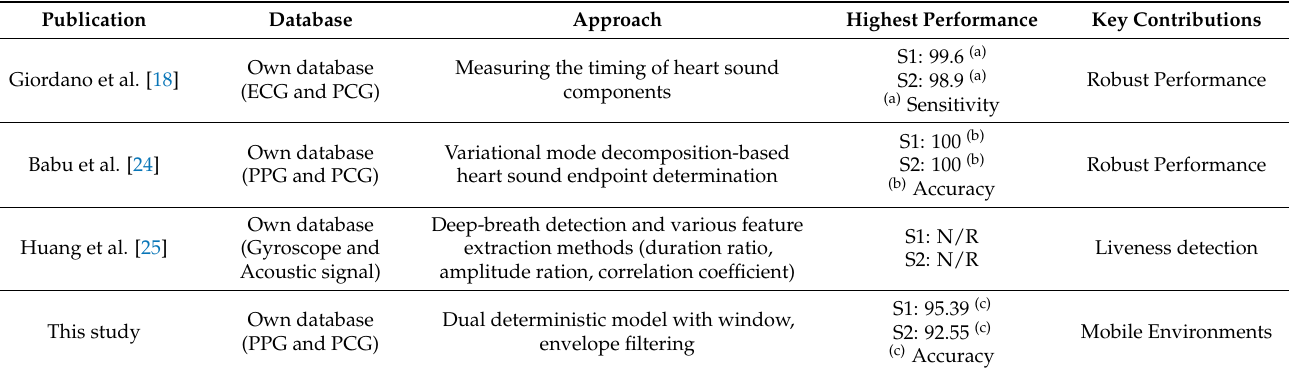
Table 9. Comparison of the approaches for heart sound